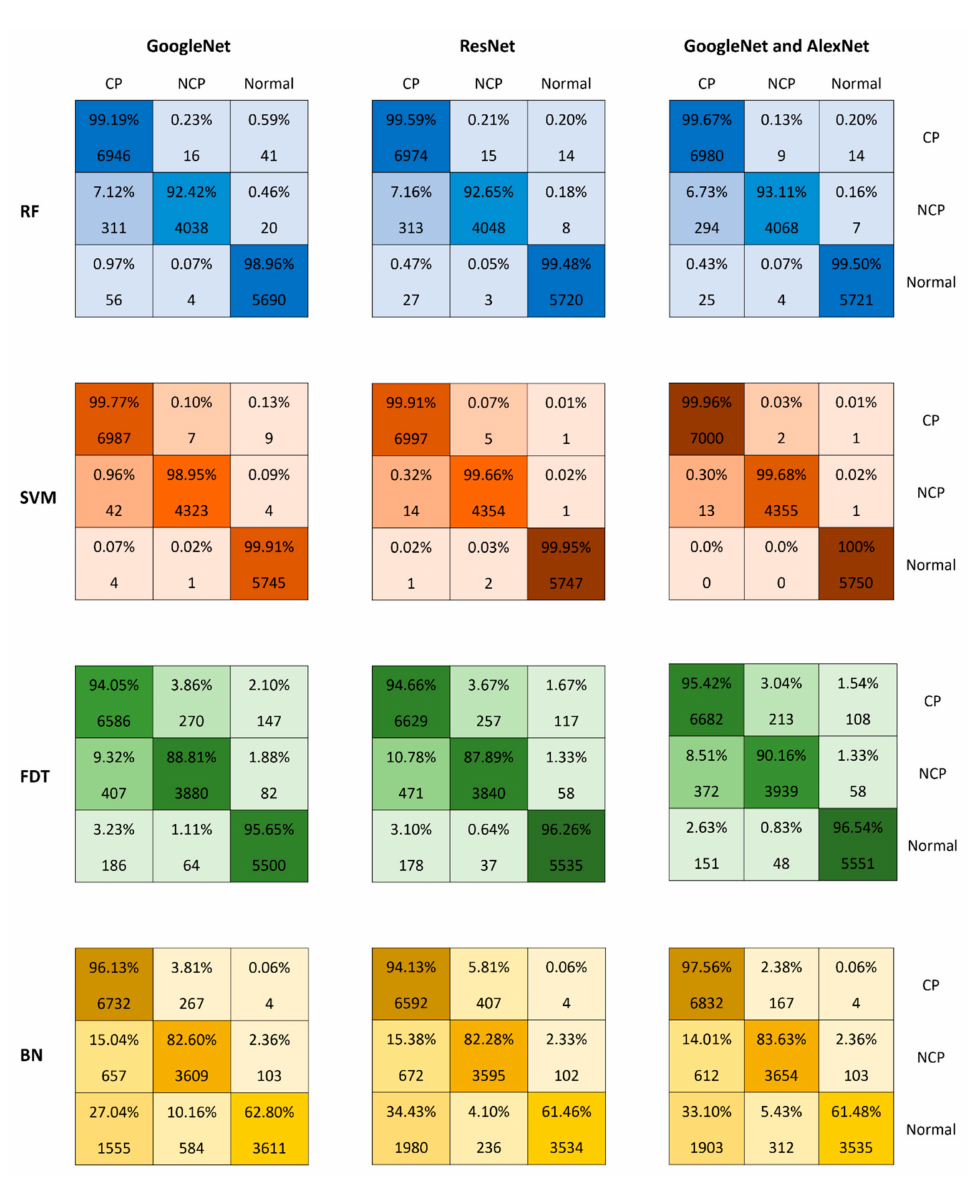
Figure 9. Comparison of the confusion matrix for different classifiers with different deep learning- based feature